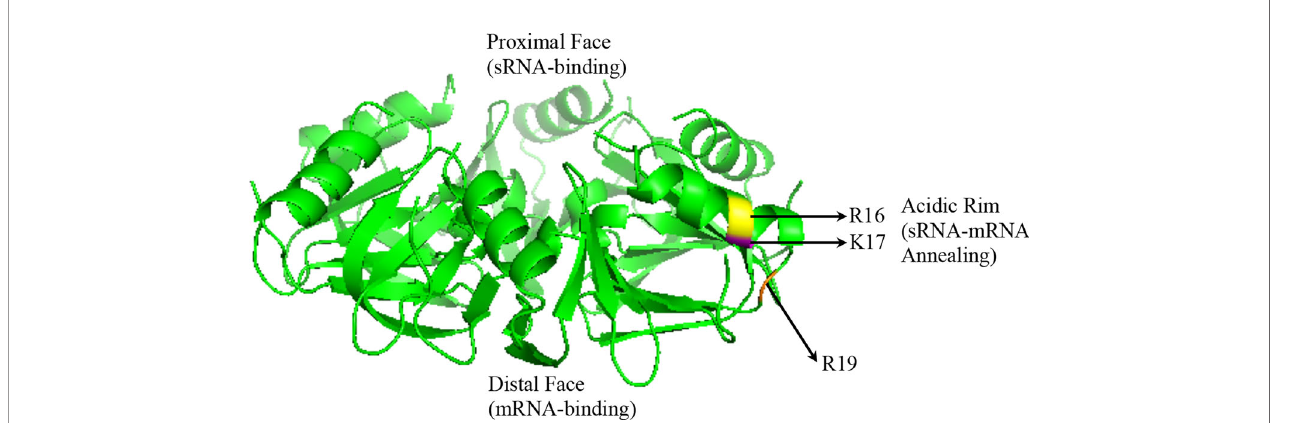
FIGURE 2 | Crystal structure of the P. aeruginosa Hfq protein adapted from 1U1S.PDB: its proximal face, its distal face, and its rim/lateral face indicated. Also indicated in yellow (R16), orange (K16), and magenta (R19) are the acidic amino acid residues on the rim (Nikulin et al.,